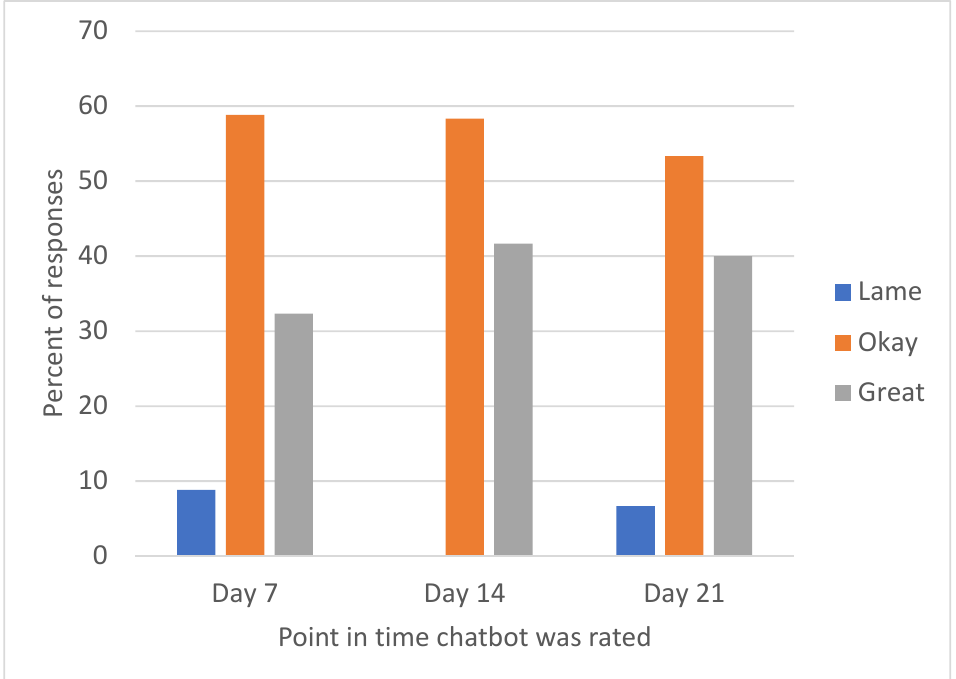
Figure 5. Participant rating for chatbot at three timepoints during the 21-Day Stress Detox programme. Day 7, n = 34; day 14, n = 24; day 21, n = 15. Glitch-free interface, ease of use, and aesthetic appeal were rated highest on a satis- faction scale (Table 4). Table 4. Mean ratings on the Chatbot Rating Scale [range between 0 (not at all) to 4 (definitely) collected at post-intervention (day 22). Chatbot Rating Scale Item